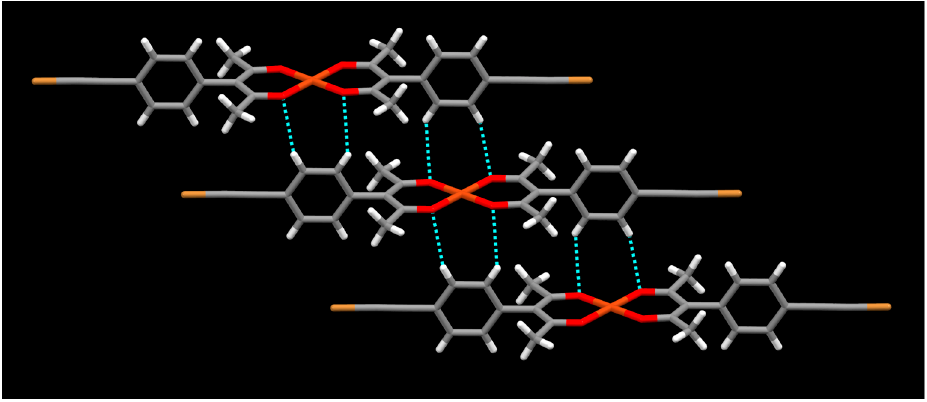
Figure 7. Crystal packing of [Cu( L2 ) 2 ]·2CH 3 CN (solvent molecules are omitted, color codes: red—oxygen; gold—bromine; orange—copper).